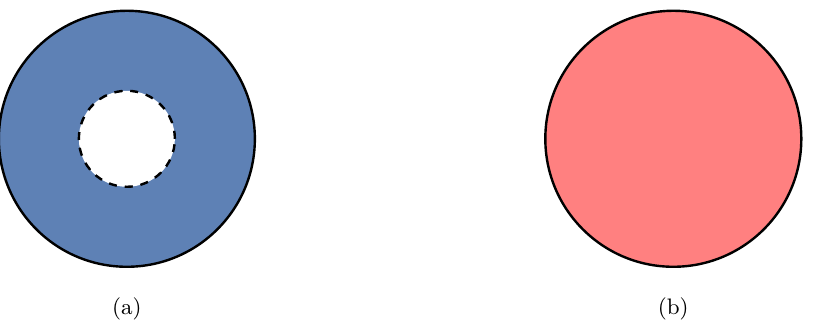
Figure 1. Visualization of the two types of topologically distinct D6-brane embeddings in spheri- cally sliced AdS 4